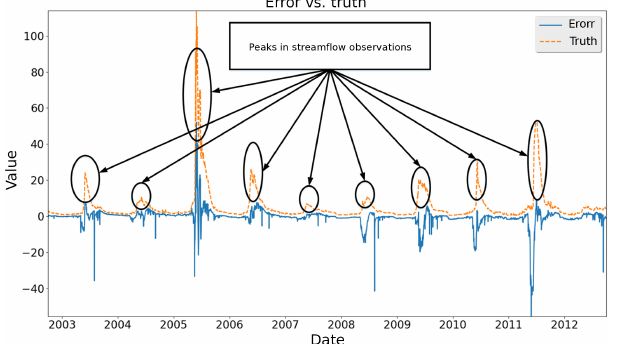
Figure 1. A traditional calibrated PRMS model streamflow predic- tion error histogram (example of Lehman Creek).